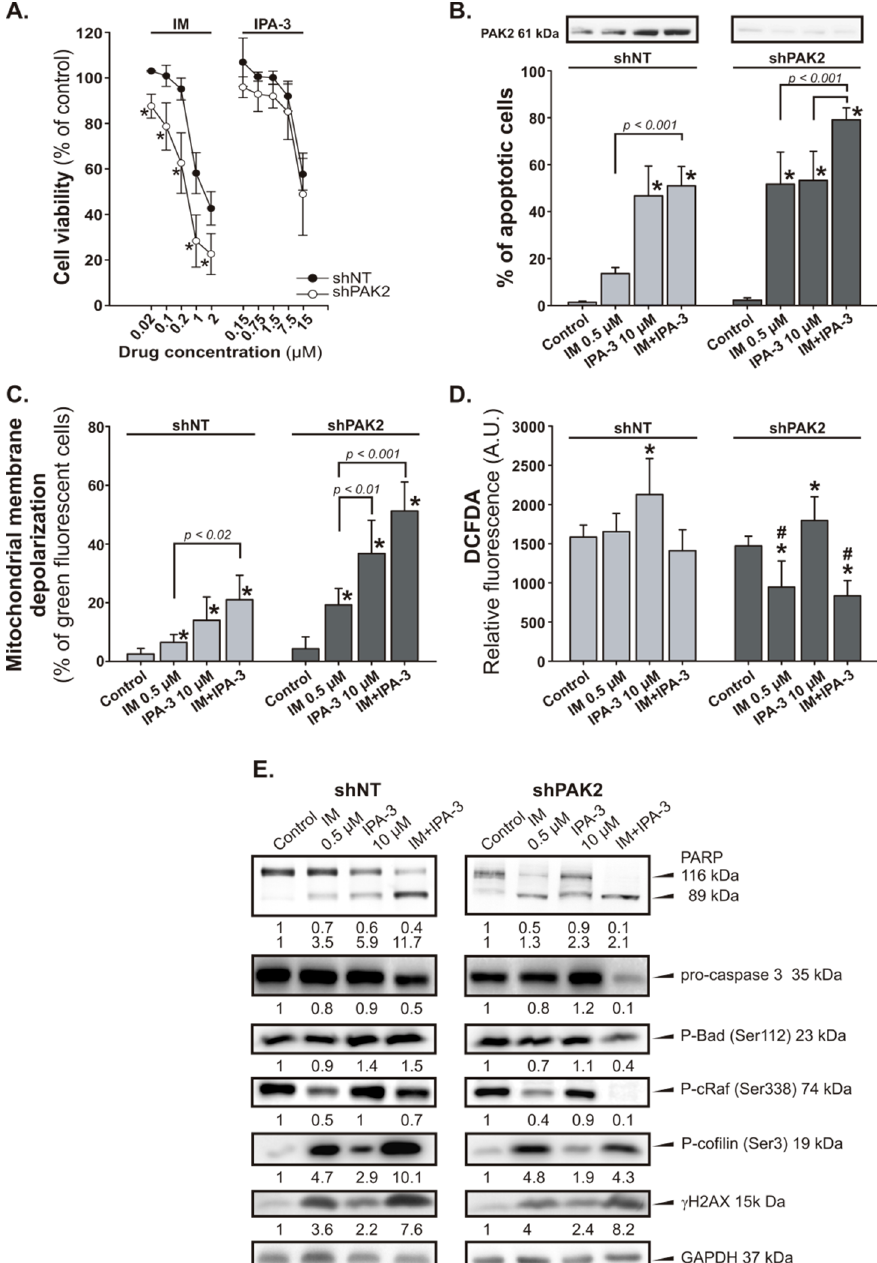
Figure 4. Effect of the combination of IM and IPA-3 on p21-activated protein kinase (PAK)2-silenced 32Dcl BCR-ABL1 cells (shPAK2). shPAK2 cells and control (shNT) cells were treated with IM and/or IPA-3 for 24 h as indicated. ( A ) Cell viability was determined using the MTT assay. Each point represents mean ± SD ( n ≥ 5), * p < 0.05 in comparison to untreated cells. ( B ) Apoptosis detection. Data are expressed as the mean annexin V-FITC/PI staining ± SD ( n = 5). * p < 0.001 in comparison to control ( C ). PAK2 expression level in shNT and shPAK2 cells was determined by Western blot analysis. ( C ) Changes in the mitochondrial membrane potential. Green fluorescence of monomeric form of JC-1 was detected, indicating dissipation of Δ Ψ m . Mean ± SD ( n = 4), * p < 0.05 value in comparison to ( C ). ( D ) Intracellular levels of reactive oxygen species (ROS) in shPAK2 cells. Data are represented as the mean DCFDA staining ± SD, * p ≤ 0.03 when compared to ( C ), # p < 0.05 when compared to the corresponding shNT cells. ( E ) Western blot of the indicated proteins; GAPDH was used as a loading control. The changes in the protein levels were estimated by quantification of band intensities with the QuantiScan ver.3.0 (Biosoft, UK) densitometry analysis software.